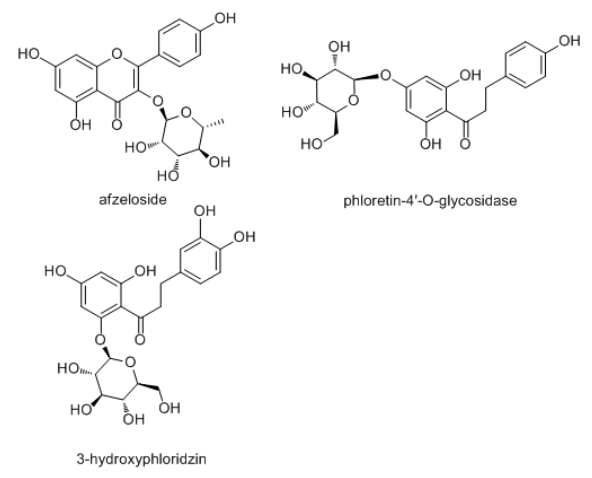
Figure 2: Structure of 3- hydroxyphloridzin, phloretin-4’- O - glycosidase and